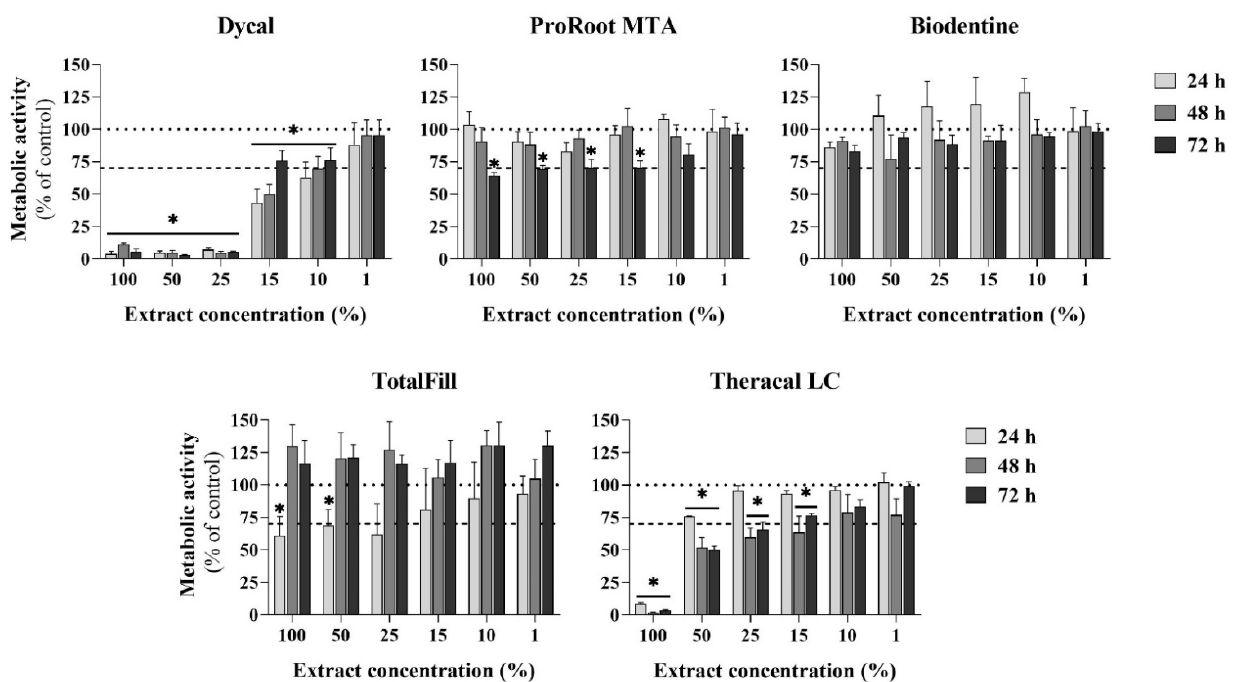
Figure 5. Cell proliferation of L929 fibroblasts exposed to undiluted (100%) and diluted (50%, 25%, 15%, 10%, and 1%) cement extracts for 24, 48, and 72 h. Results are expressed as percentage of control, set at 100% (dotted line); the “cut-off” value of 70% of the control is also shown (dashed line). * Statistically significant difference from the control, p ≤ 0.05.